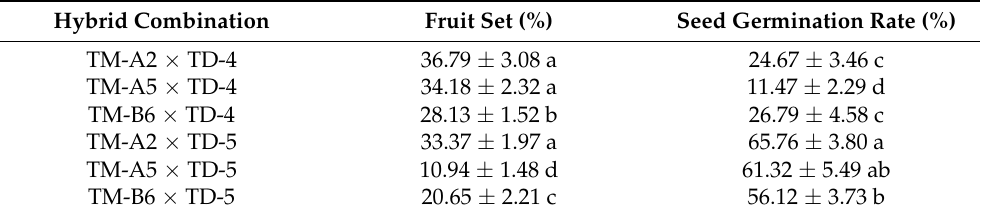
Table 7. Statistics of fruit setting rate and seed germination rate using one-year-old pollen of T. distichum var. distichum TD-4 and TD-5 stored at − 20 ◦ C as the pollen donor for